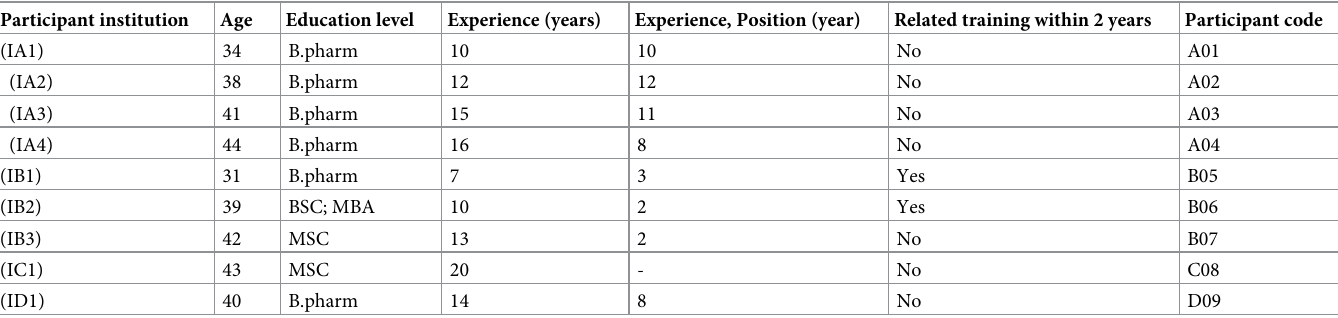
Table 2. General information of study participants, July to August